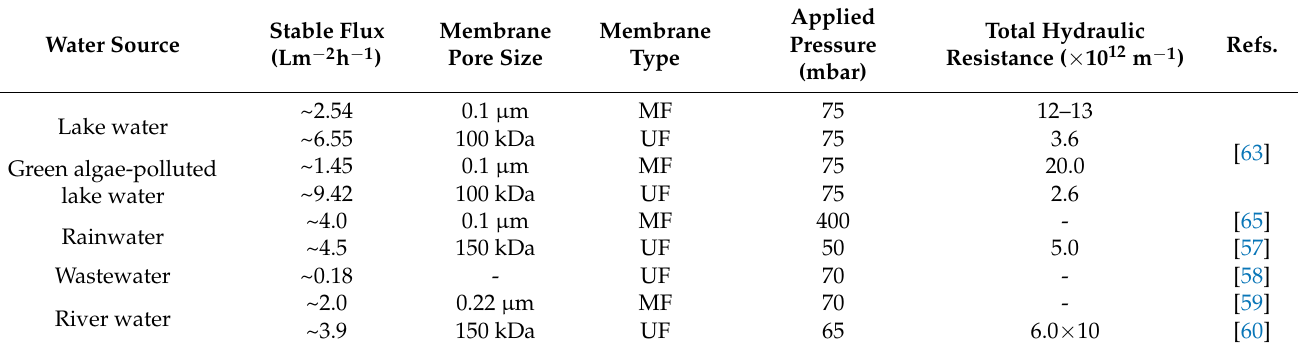
Table 1. Overview of membrane filtration performance reported for gravity-driven membrane systems fed with different types of